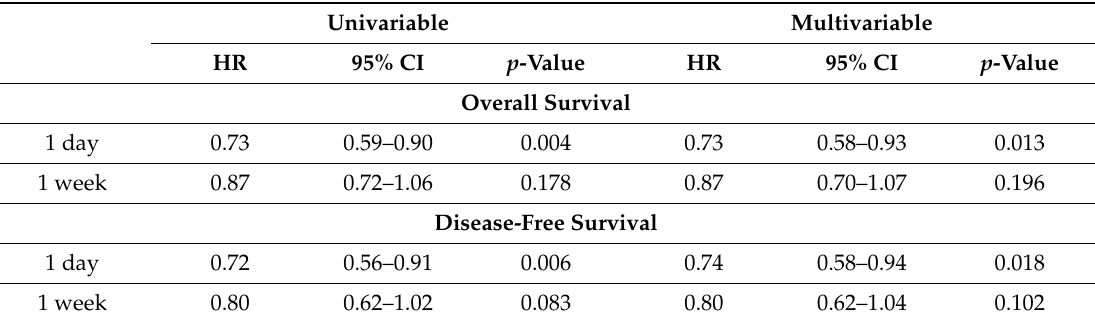
Figure 3. ( A ) Kaplan–Meier curve for overall survival (OS) comparing patients where COP decreased or increased from the preoperative measurement to the postoperative measurement on day 1, and ( B ) Kaplan–Meier failure function for disease-free survival (DFS). Table 3. Change in postoperative COP compared to the preoperative value: univariable and multivariable time-to-event